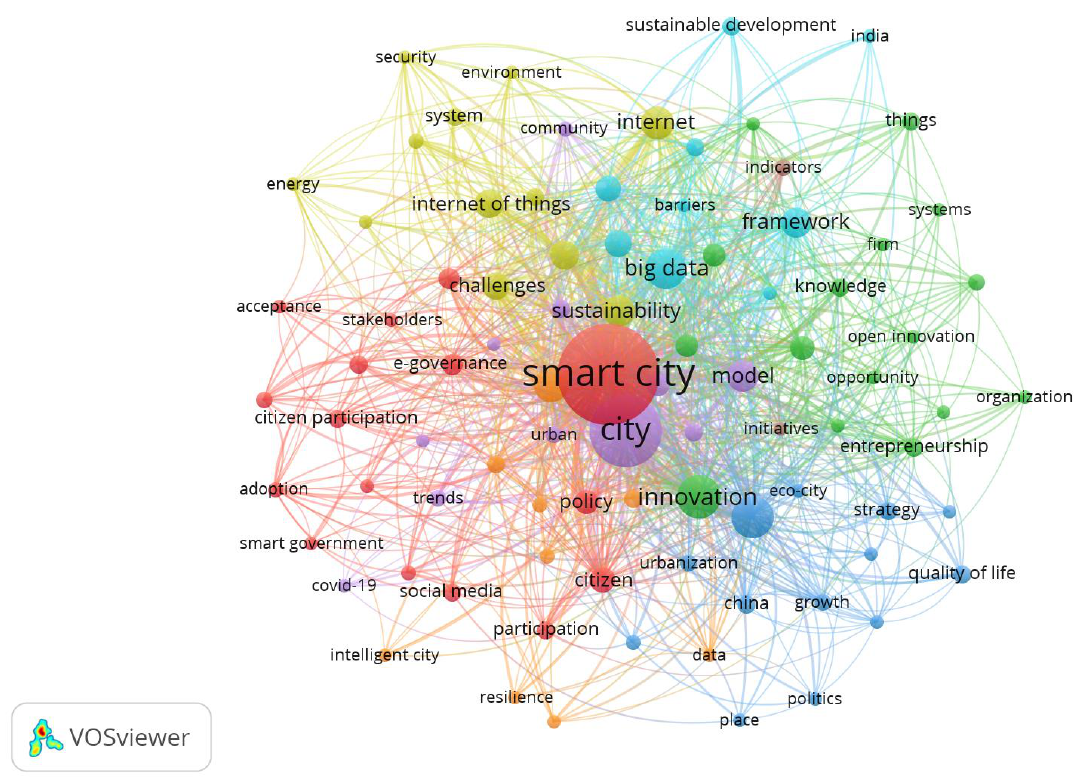
Figure 5. Network visualization Expansion Period.